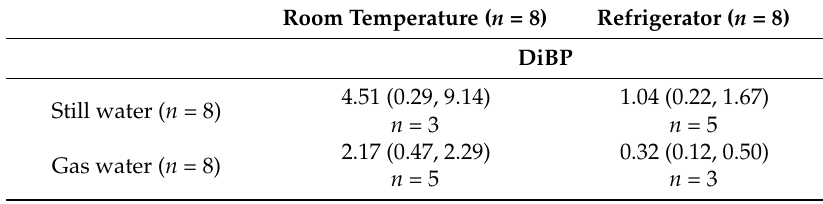
Table A1. Concentrations of phthalates in bottled water by characteristic and storage